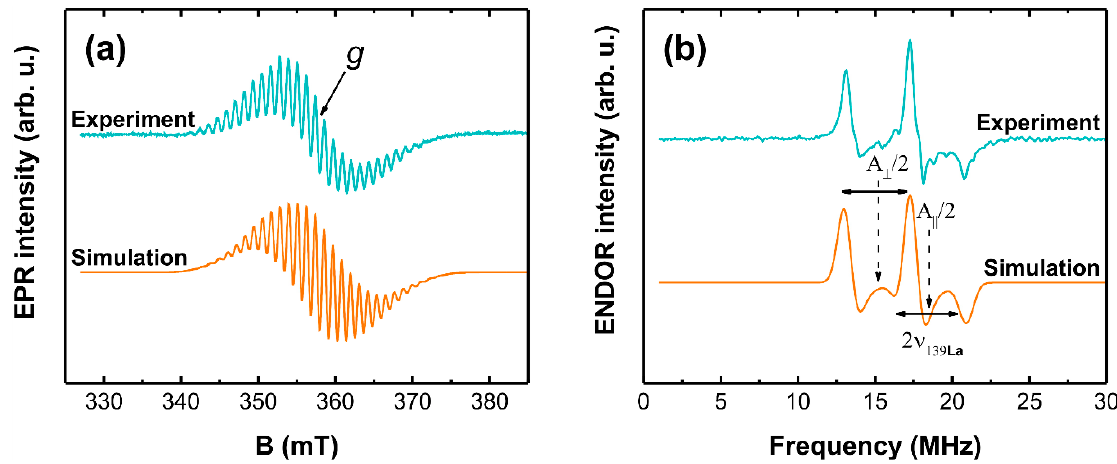
Figure 5. ( a ) EPR and ( b ) ENDOR spectra simulations of LaOCl sample with 0.1 mol% Cr. The EPR spectrum exhibits a well ‐ resolved HF structure with approximately 1.15 mT average separation between the lines, which corresponds to a HF coupling value of A ≈ 32 MHz. The number and relative intensities of the lines could be tentatively accounted for in a model with S = 1/2 interacting with four equivalent nuclear spins I = 7/2. From the naturally abundant nuclei in the LaOCl matrix, only 139 La have I = 7/2. ENDOR spectra, in general, are determined by the relative magnitude of HF and nuclear Zeeman interactions [73]. The fact that we observe the ENDOR signal at A /2 ≈ 16 MHz implies that our case corresponds to a Larmor-split HF-centered doublet. Consequently, the nucleus responsible for the EPR spectrum HF structure can be identified from half the distance between the ENDOR lines. As a result, we can estimate that the Lar- mor frequency is 2.1 MHz directly from the experiment, which is close to the value of 139 La at B = 345 mT (the magnetic field at which ENDOR was acquired). The asymmetric